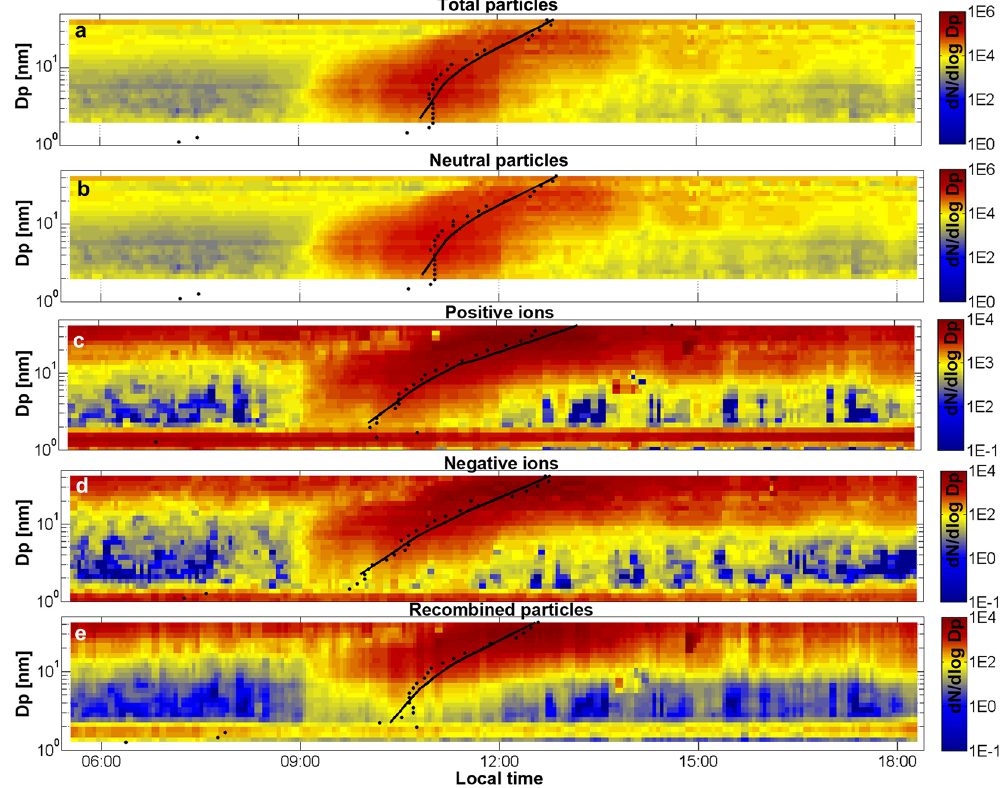
Figure 2. NPF event of 12 August 2012 as measured with the NAIS. Shown are (a) total particles, (b) neutral particles, (c) positive ions, (d) negative ions and (e) calculated neutral particles from ion–ion recombination. Black-filled circles denote the concentration maxima for each size class, while black lines are smoothed fits in order to obtain continuous growth